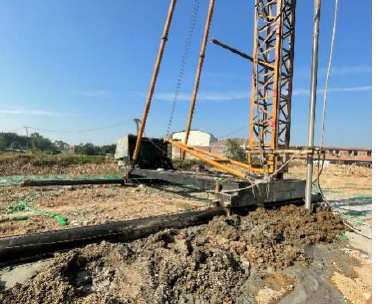
Figure 1. Deep mixing pile machine used in this study.